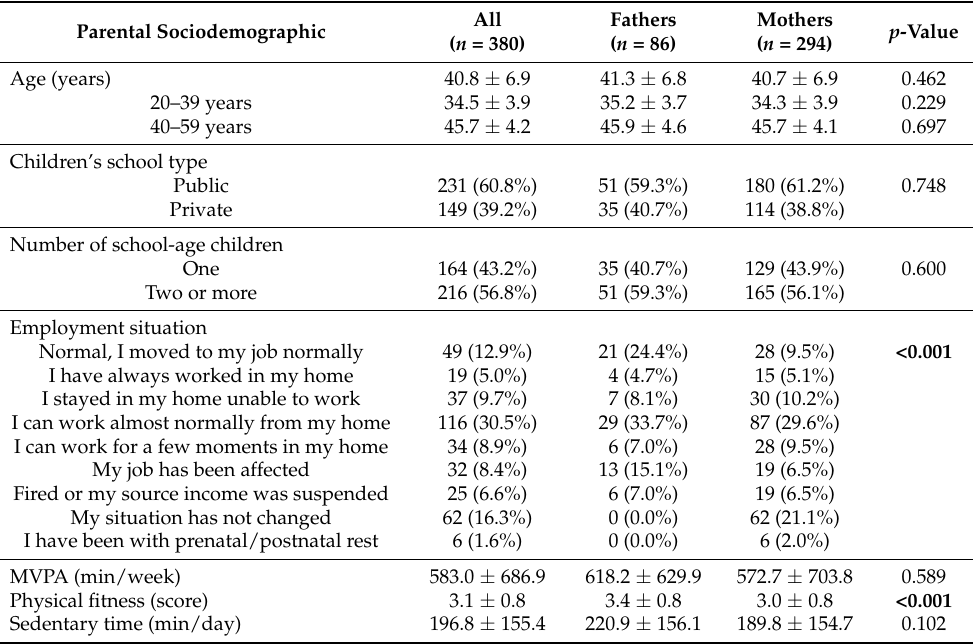
Table 1. Baseline sociodemographic characteristics of